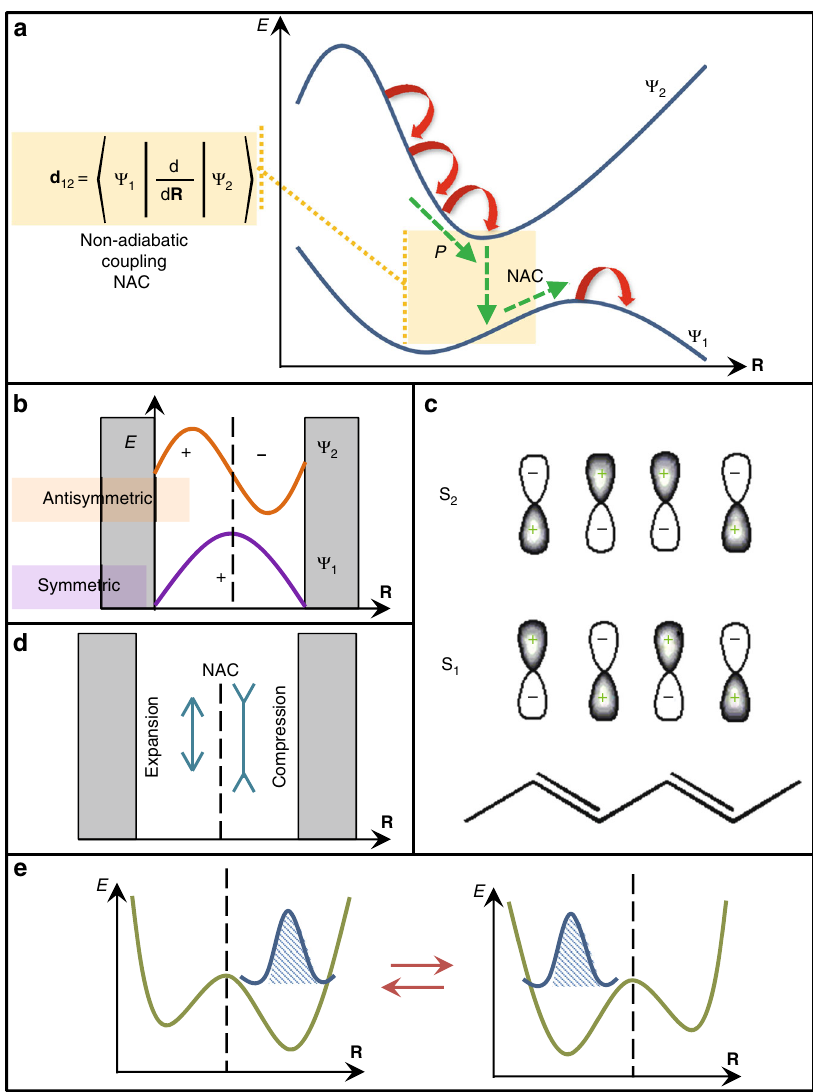
Fig. 1 Electronic and vibrational coupling during internal conversion. a Schematic representation of dynamics through the non-adiabatic region (colored box) on two potential energy surfaces de fi ned by electronic wavefunctions Ψ 1 and Ψ 2 with dependence on electronic degrees of freedom R . During internal conversion, the ef fi ciency of the transition of the photoexcited wavepacket from the upper to the lower surface is driven by the derivative non-adiabatic coupling d 12 . On the upper surface, the wavepacket is pushed towards the crossing by the Pechukas force, P , acting in the direction of the non-adiabatic coupling vector (NAC). b The wavefunction on a fi nite molecule adopts a standing wave pattern according to the particle (exciton) in a box model exhibiting either “ symmetric ” ( Ψ 1 ) or “ antisymmetric ” ( Ψ 2 ) form. The non-adiabatic transition from Ψ 2 to Ψ 1 corresponds to an antisymmetric-to- symmetric transition between neighboring wavefunctions. c The two lowest energy excited states in the polyacetelene conjugated polymer exhibit A g and B u symmetries. d The resulting vibrational excitation has an asymmetric form where the left and right part of the system experience structural deformations with opposite phase (expansion and compression). e Sloshing of the localized wavefunction between left and right sides of the double well potential is initiated by the asymmetric vibrational excitation which causes periodic modulations in the potential energy surface on the lower